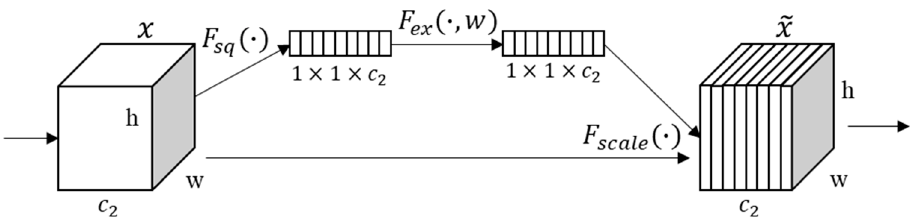
Figure 6. Squeeze-and-Excitation (SE) module [39]. The module is mainly composed of three parts: squeeze, excitation and scale. F sq ( · ) represents the squeeze transformation, F ex ( · , w ) represents the excitation transformation and F scale ( · ) represents the scale transformation. The core module of SENet is divided into three parts: squeeze, excitation and scale.